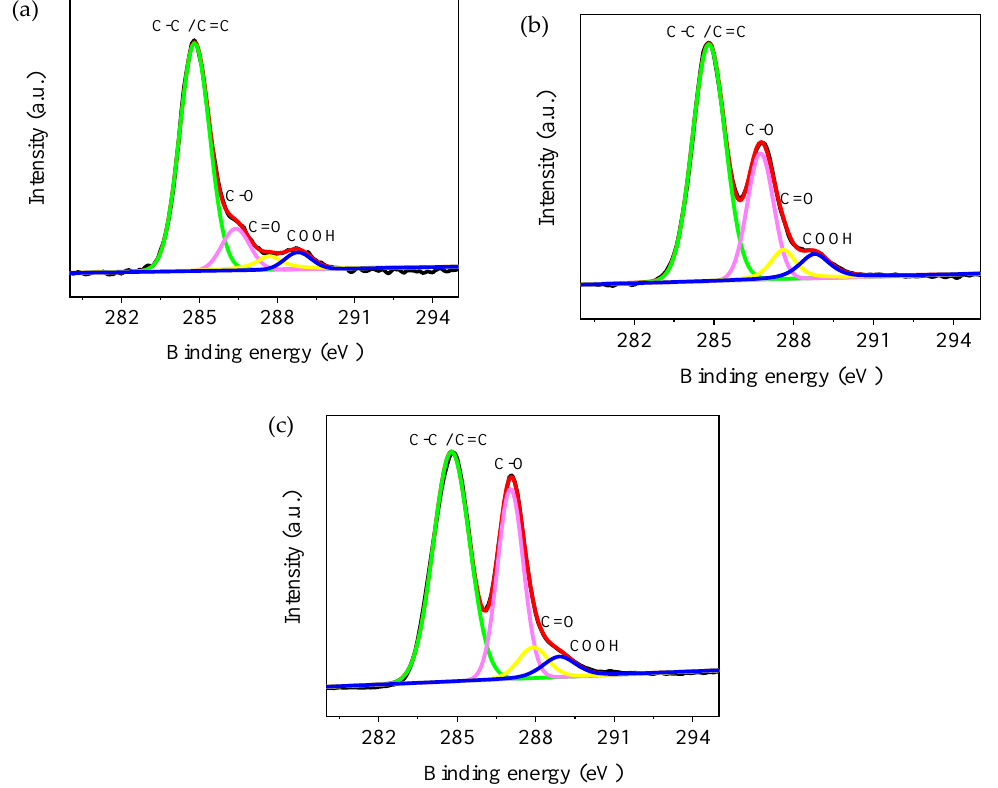
Figure 6. XPS spectra of C 1 s of the GO layers with ( a ) 0.05 ωt%, ( b ) 0.5 ωt%, and ( c ) 2 ωt% GO.